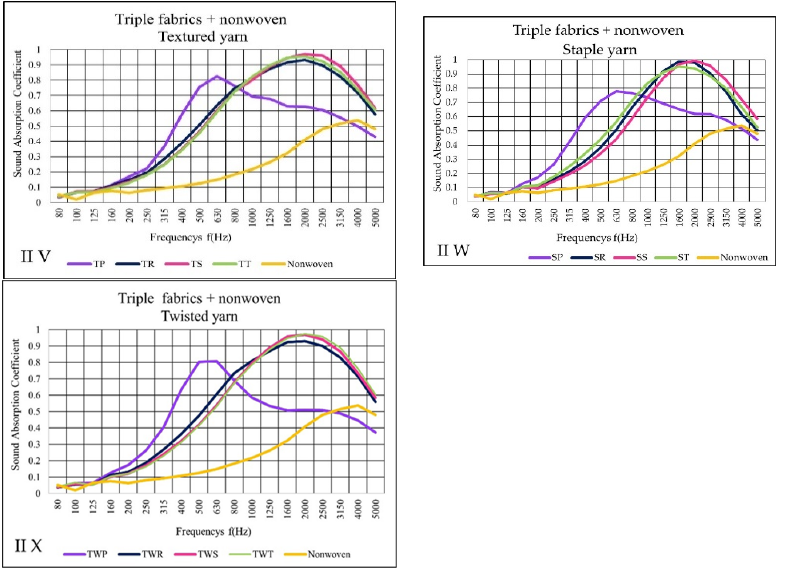
Figure 12. Sound absorption coefficient ( α ) versus frequency f (Hz) result of II variant ( V – X ) triple woven fabrics + nonwoven fabric.